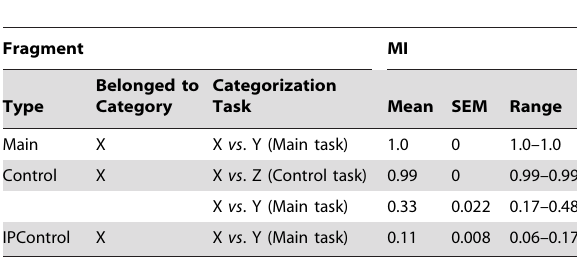
Table 1. Mutual Information of Individual Fragments in